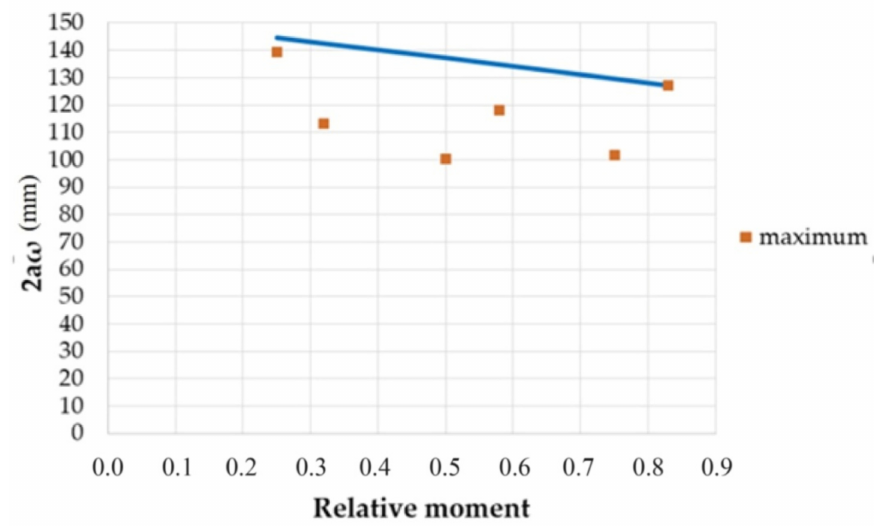
Figure 33. Maximal section 2a ω by relative moment. Table 11 compiles the results of crack width calculations from Formula (6) at selected load levels with the use of Relationship (9). Table 11. Summary of the crack width calculations at selected load